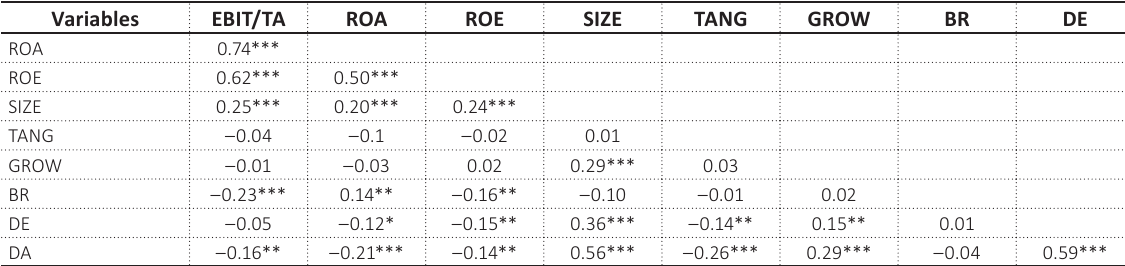
Table 4. Correlation coefficients between the variables